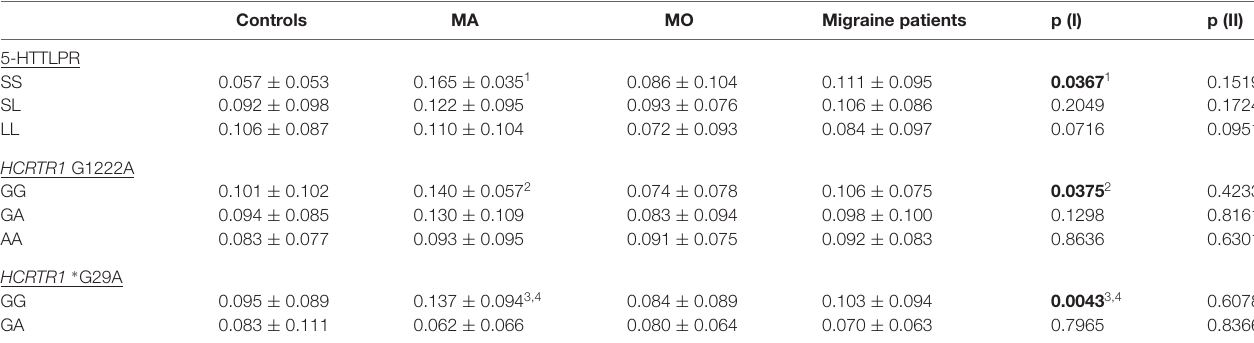
TABLE 5 | 5-HT concentration in MA, MO, both migraine patients (MA+MO) and control subjects regarding different genotypes of 5-HTTLPR, HCRTR1 G1222A, and ∗